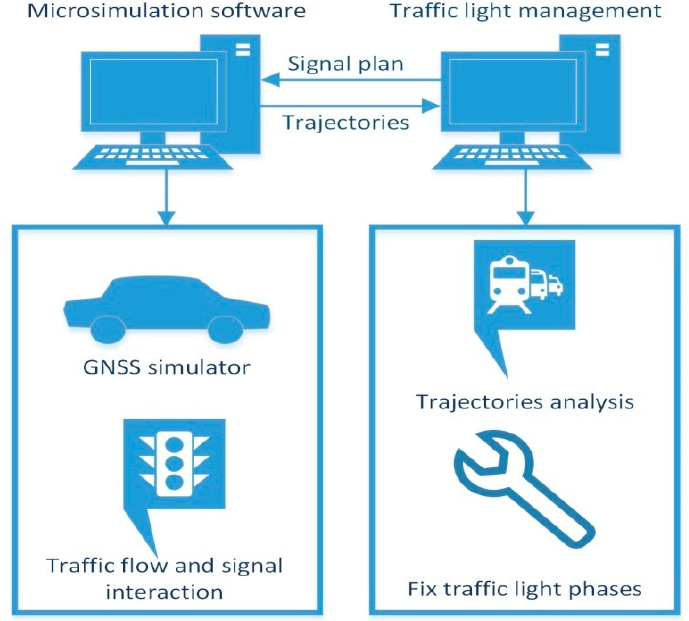
Figure 2. Intelligent Transportation Systems (ITS) laboratory for traffic signal algorithms testing and development. and